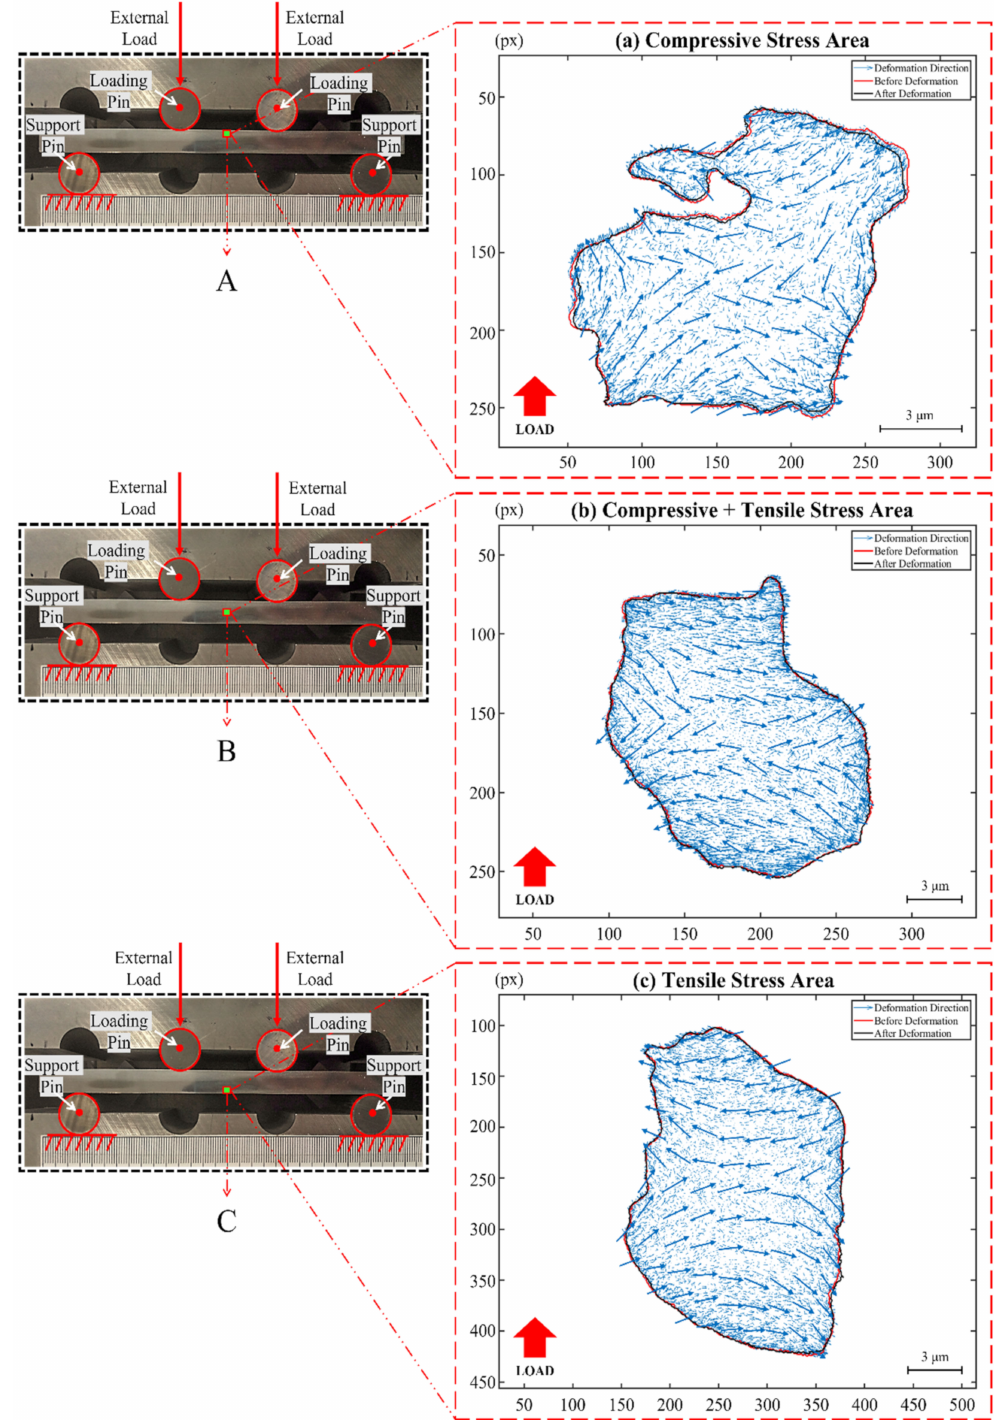
Figure 16. The grain-level analysis of deformation direction for understanding the internal deforma- tion trends on the grain area: ( a ) compressive stress area, ( b ) compressive and tensile stress area, and ( c ) tensile stress